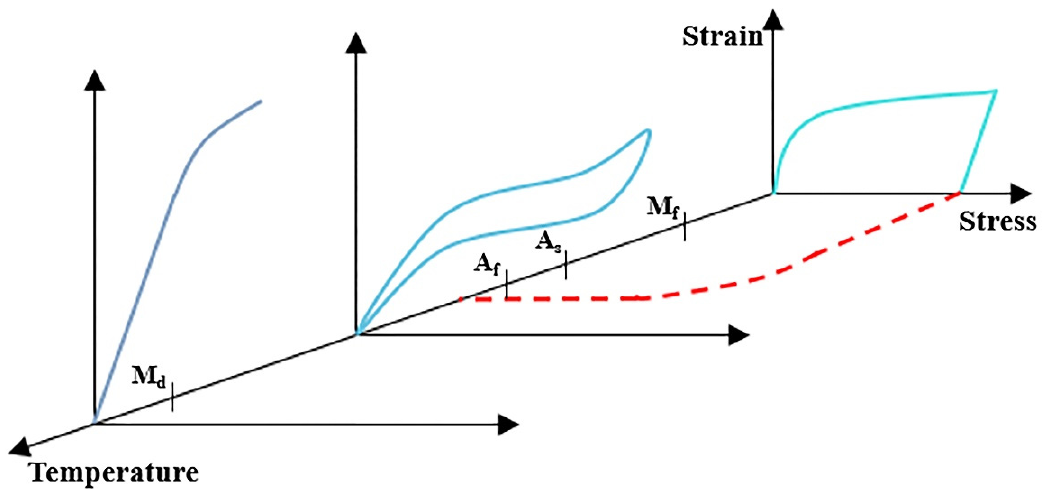
Figure 5. The alloy exhibits different mechanical behaviors at different temperatures.